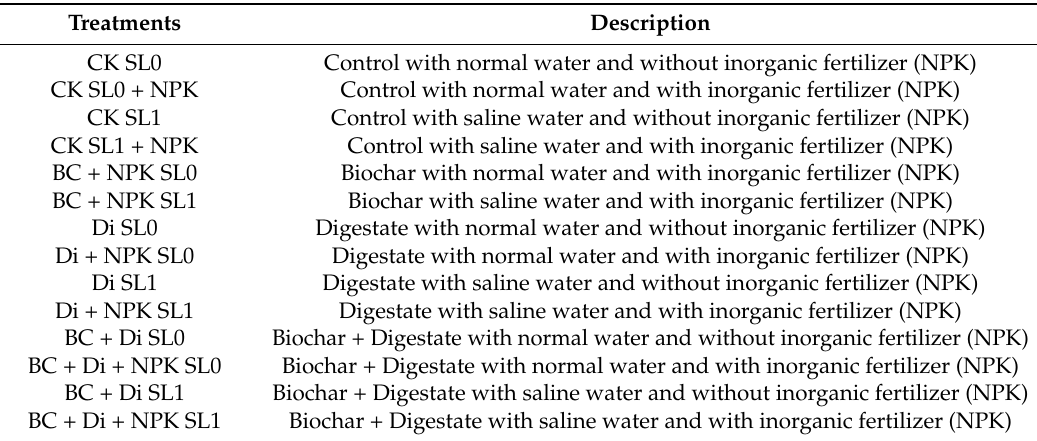
Table 2. Experimental treatment design.